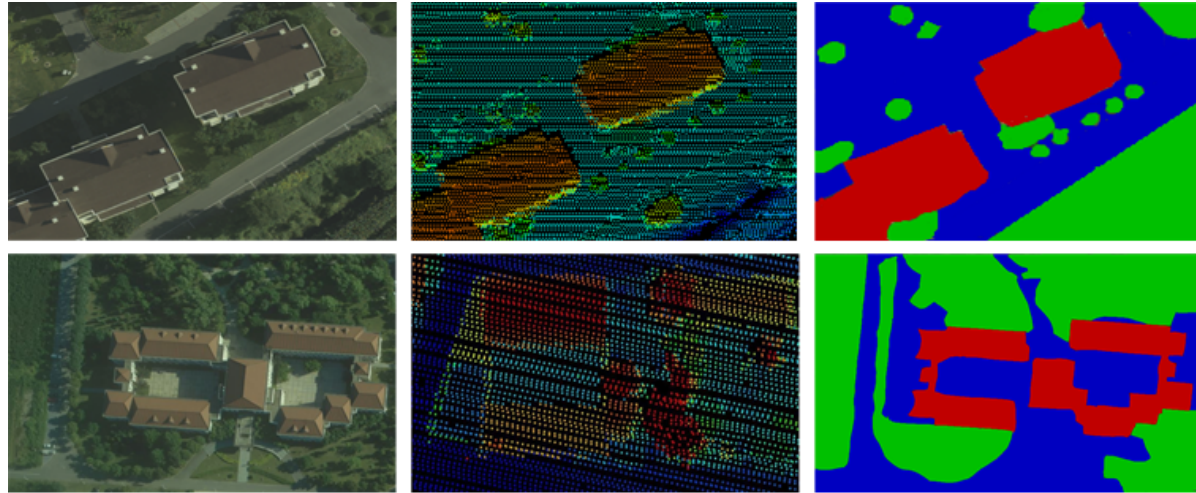
Figure 5: The classification result from the MSMSH-CRF model on the Beijing Airborne Data. Left : remote sensing image, Middle : LiDAR point cloud, Right : classification result (red - building, blue - road, green - vegetation).